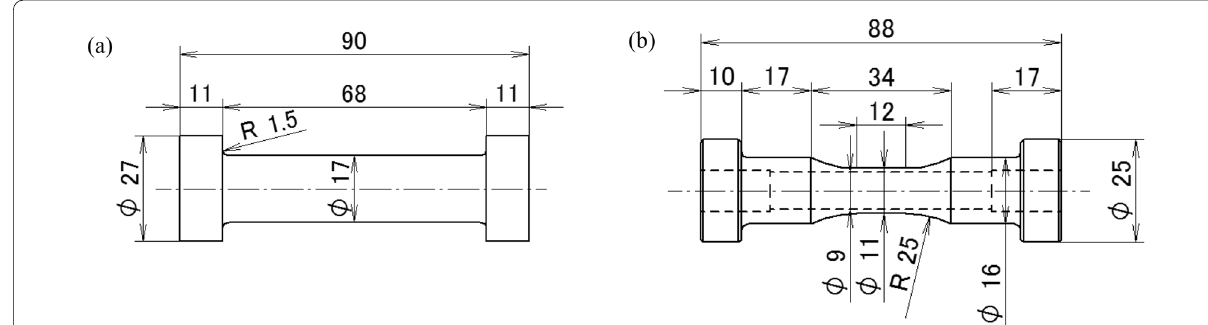
Figure 5 Shape and dimensions of the specimen after ( a ) L-PBF and b the machining process